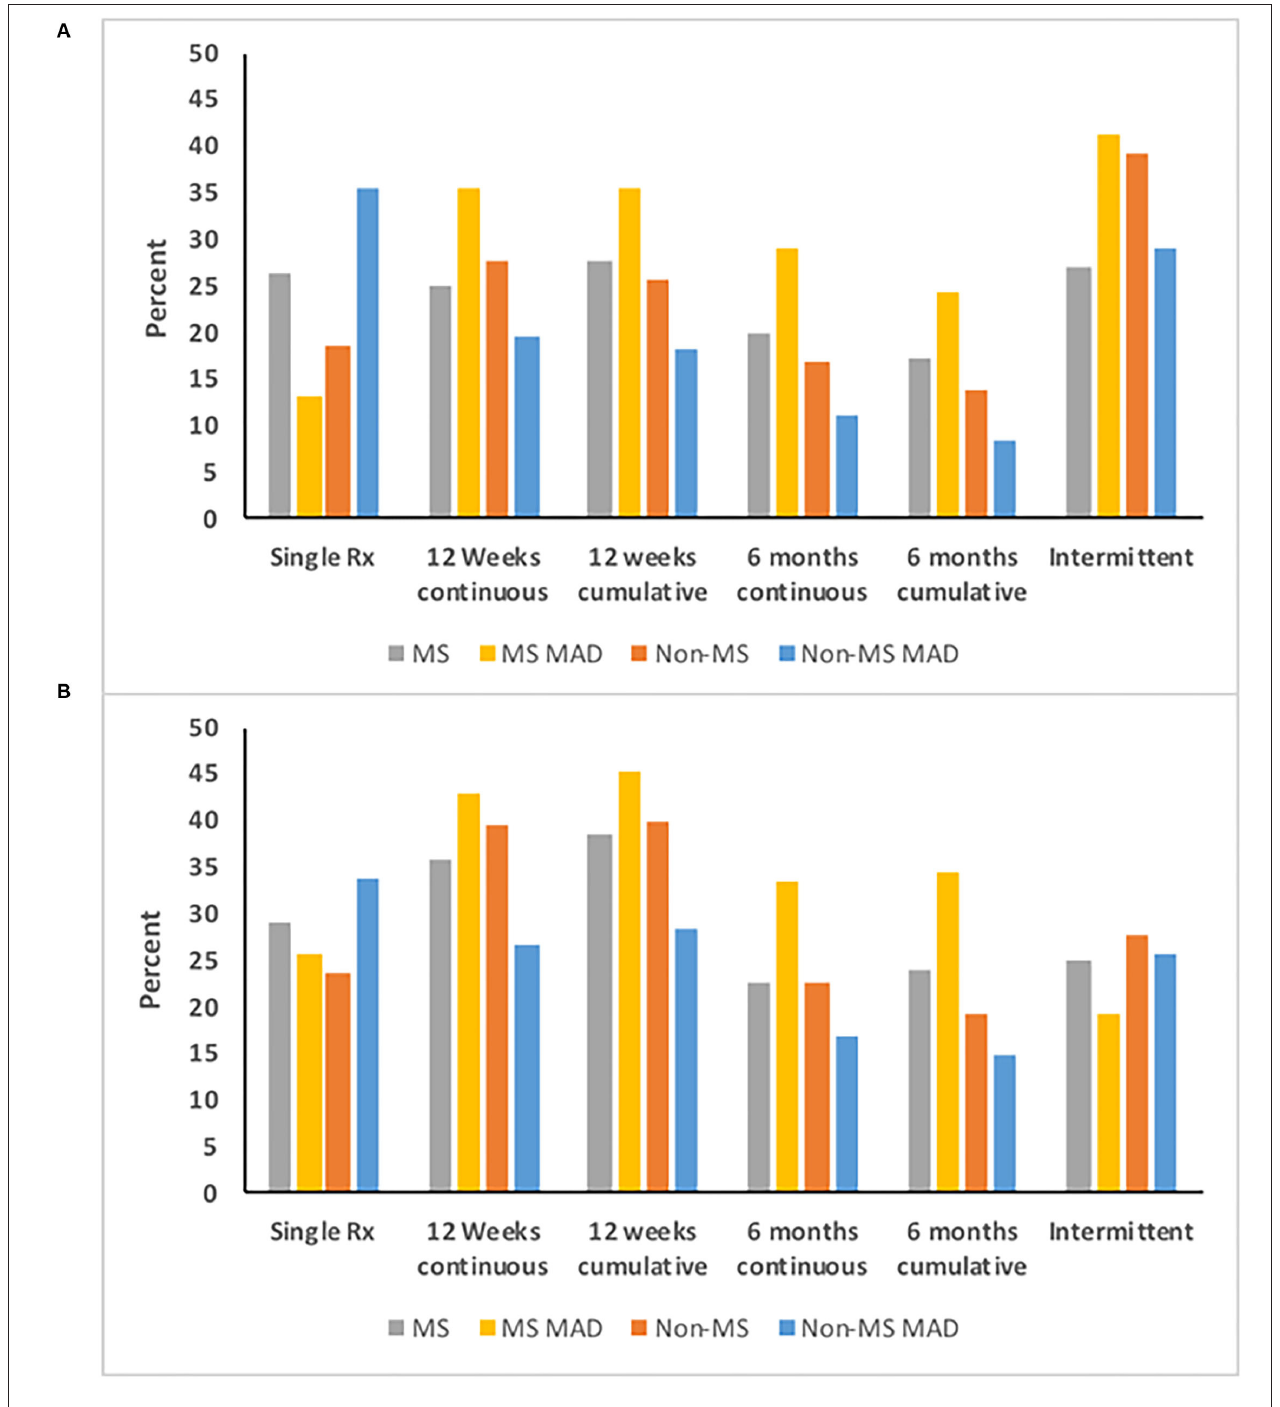
FIGURE 5 | Persistence on (A) Benzodiazepines and (B) Z-drugs according to multiple sclerosis (MS) and mood/anxiety disorder (MAD) status.